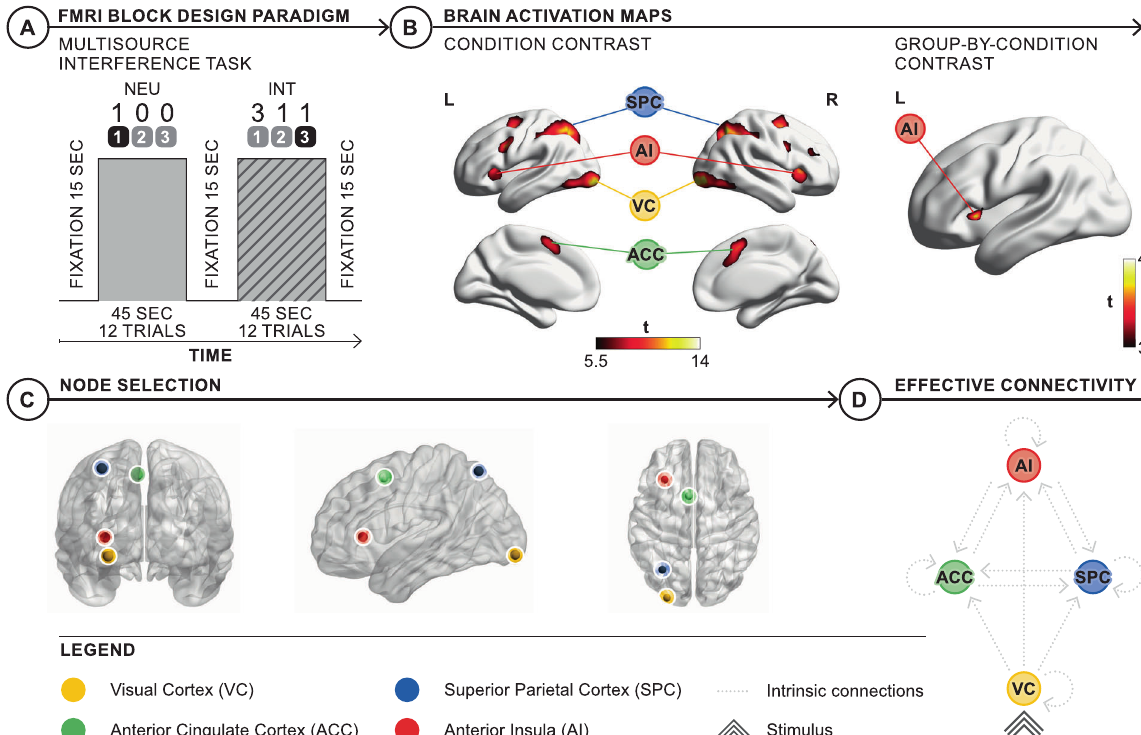
Fig. 1 fMRI task and modeling. A Timing and example stimuli corresponding to neutral and interference conditions. Stimuli were presented for 2.5 s with individual trials organized in blocks of the same condition. Four blocks each of alternating neutral and interference conditions were interspersed by a fi xation period. B Brain activation mapped to the cortical surface; canonical CCS regions showed strong and signi fi cant activation in the main effect of interference contrast ( p < 0.001 uncorrected). The group-by-condition contrast showed increased activation in the left AI in EP participants at a permissive cluster-forming height threshold ( p < 0.01 uncorrected). C Node selection for DCM model space: Time series from AI, ACC, and SPC and the visual cortex (VC) were extracted from the left hemisphere to model task-related modulations and stimulus input, respectively. D DCM model space common to all models: stimuli enter directly into VC, interference stimuli were able to modulate lower-order connections in a feedforward manner, with subsequent modulation of higher-order connections between ACC, SPC, and AI connected in a feedforward and feedback